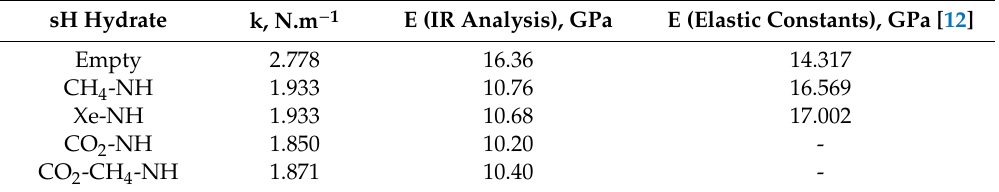
Table 4. Hydrogen bond force constant ( k ) and corresponding sH hydrate Young’s modulus ( E ) from hydrogen bond stretching